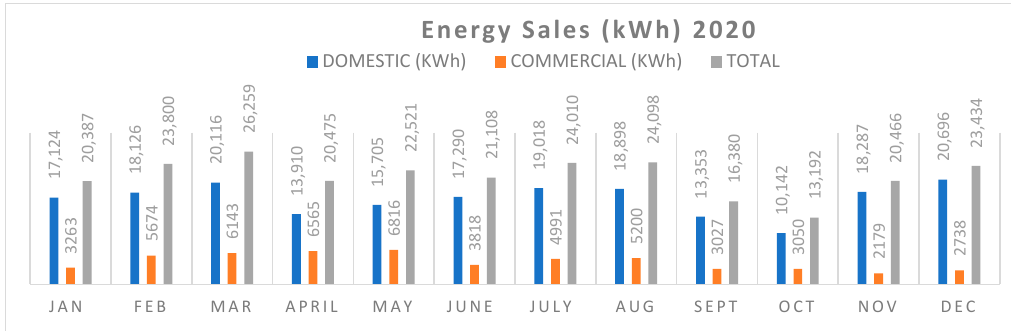
Figure 3. Energy Sales January–December 2019.